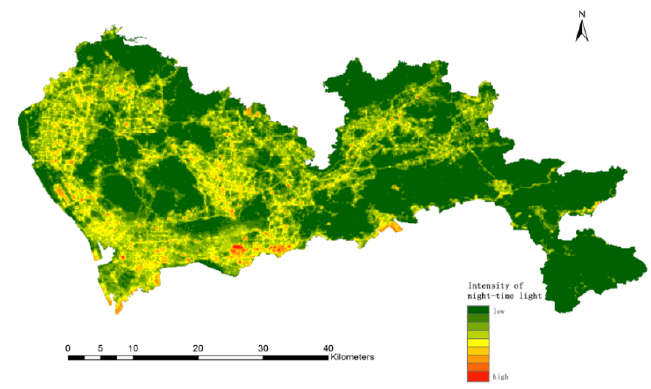
Figure 6. Intensity of night-time light retrieved from remote sensing in